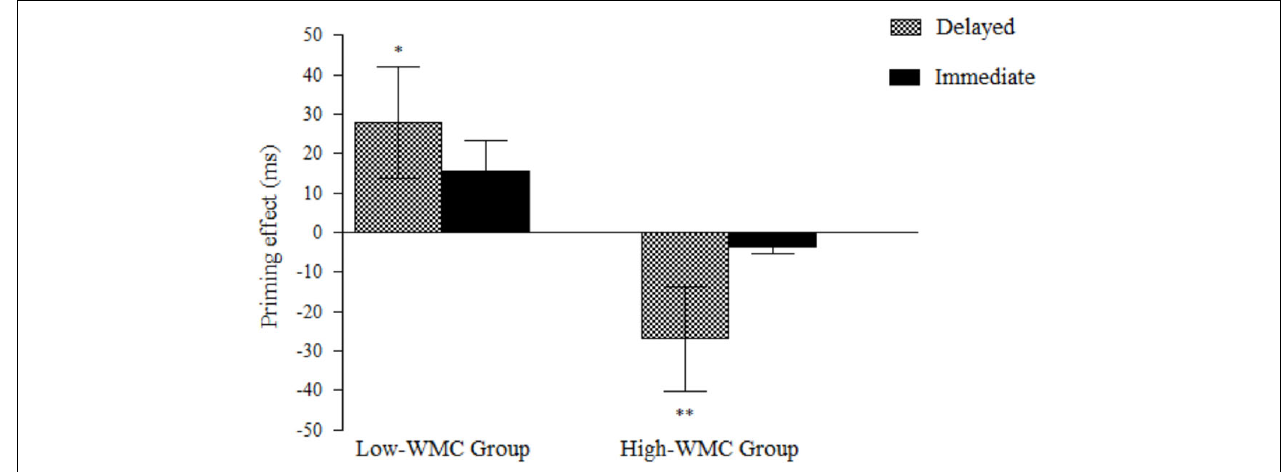
FIGURE 2 | Semantic priming effects (unrelated minus related) for delayed and immediate masking for low-WMC and high-WMC participants. The vertical lines depict the standard error of mean priming scores for each condition. Statistically significant priming effects are highlighted by asterisks (* p < 0.05; ** p <